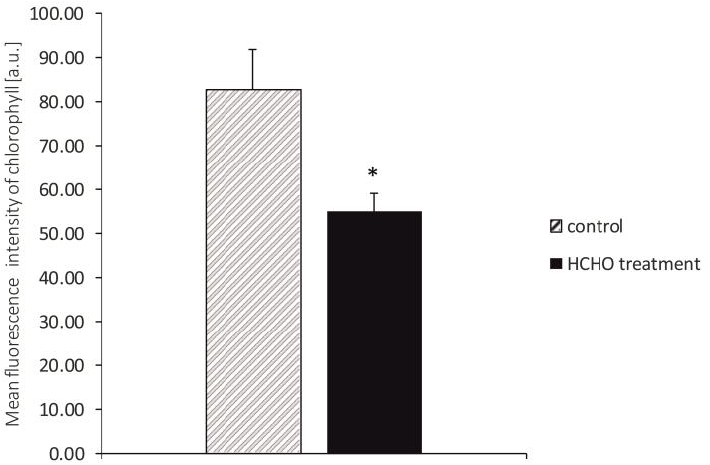
Figure 5. Effect of treatment with gaseous formaldehyde applied as 20 mg m − 3 on intensity of chlorophyll fluorescence in C. comosum leaf tissues after the 48 h of plant exposure. * indicates values that differ significantly from the control at p < 0.05.